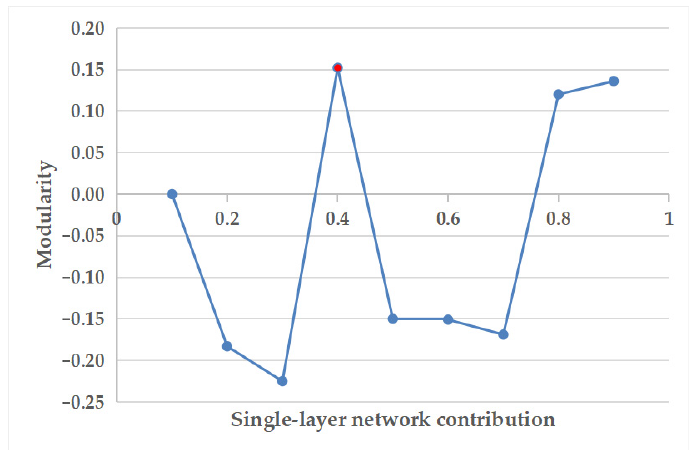
Figure 9. Relationship between modularity and single ‐ layer network contribution.